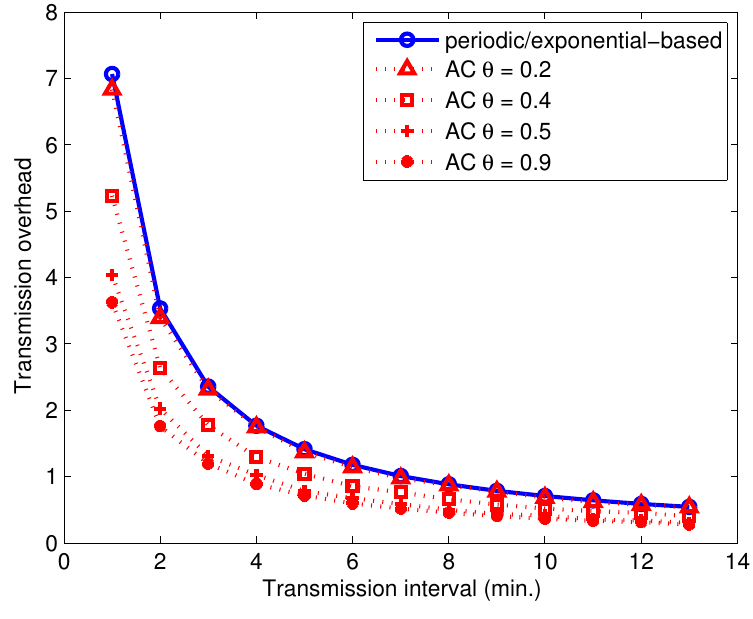
Figure 8. Energy overhead of the tested